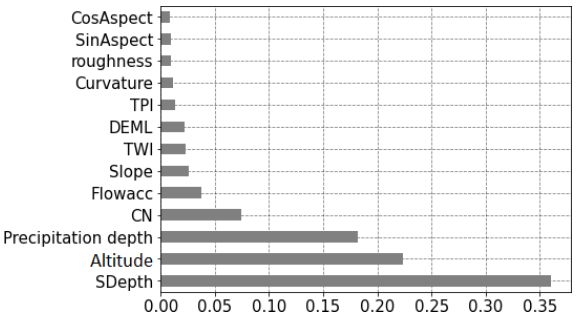
Figure 8. Predictive feature importance for RF-SA1&2